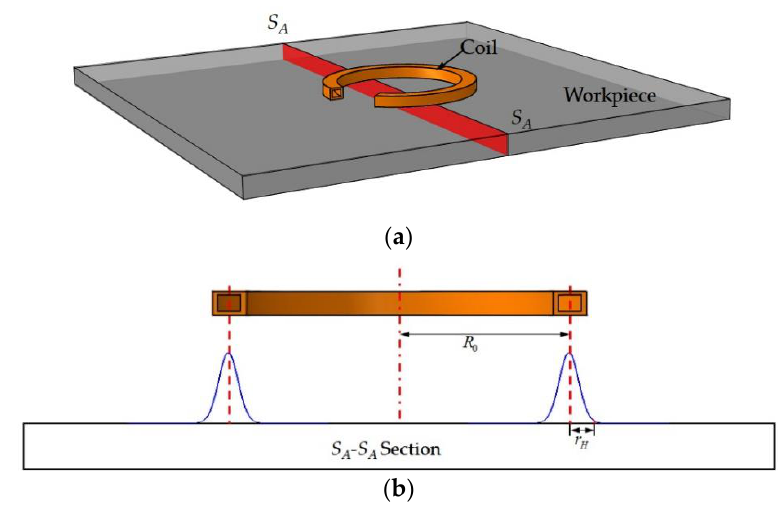
Figure 2. Diagrams of computation model and heat source distribution: ( a ) Computation model and ( b ) Gaussian distribution of the heat source.